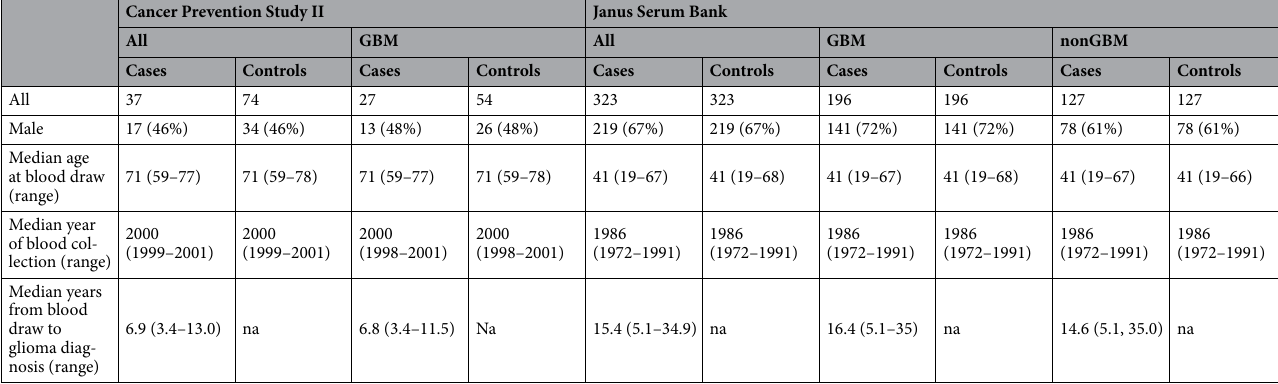
Table 1. Incident primary intracranial glioma cases (ICD9 and 10 topography codes: 191 and C71, respectively) were comprised of WHO grade IV glioblastomas (GBM) (ICD-O-3 histology code: 9440-9441), and lower grade